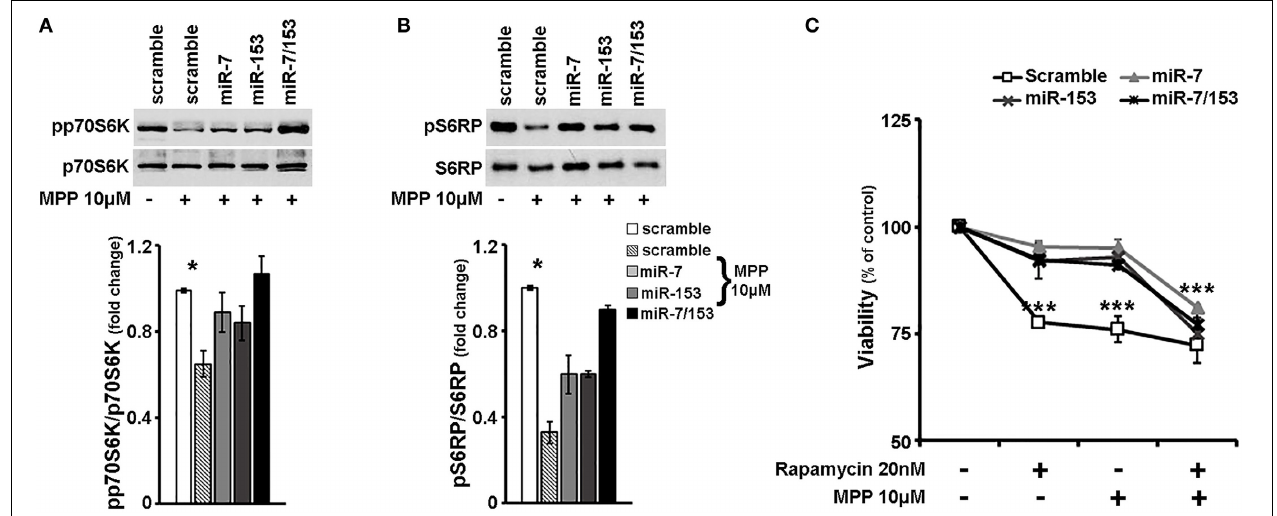
FIGURE 6 | miR-7 and/or miR-153 attenuated MPP + -induced neurotoxicity via upregulation of rapamycin sensitive mTOR pathway. (A,B) Six to seven days old primary cortical neurons were transduced with adenoviral particles expressing scramble miR, miR-7, miR-153, or both miR-7/153. After 24h, transduced neurons were exposed for additional 24h to 10 μ M of MPP + . Equal amounts of total protein from lysates of transduced cortical neurons cultured for 24h in the presence of 10 μ M MPP + were analyzed on 10% SDS-PAGE and immunoblotted with antibodies specific for phosphorylated forms of p70S6K (A) and S6RP (B) . To ensure equal loading membranes were re-probed against p70S6K and